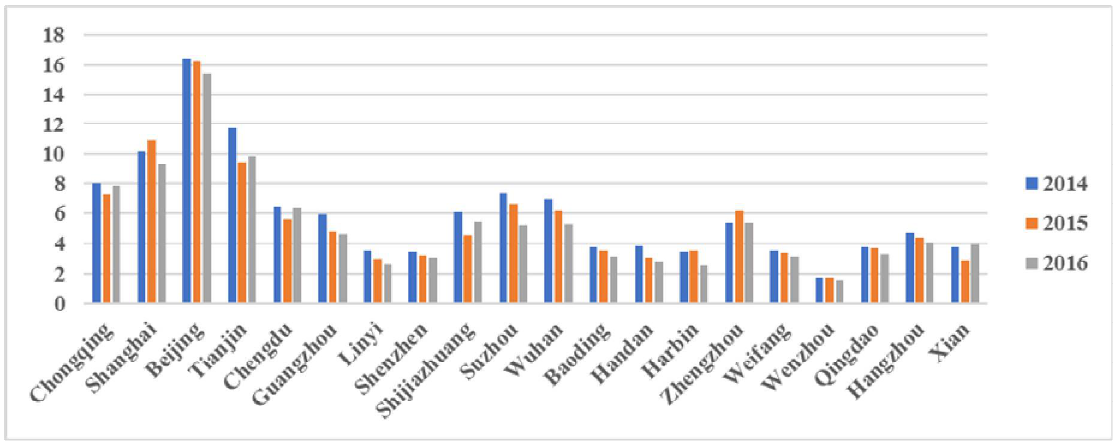
Figure 4. PM 2.5 -related economic losses as a result of health impacts in 20 Chinese major cities in the lower bounds during the period 2014–2016.